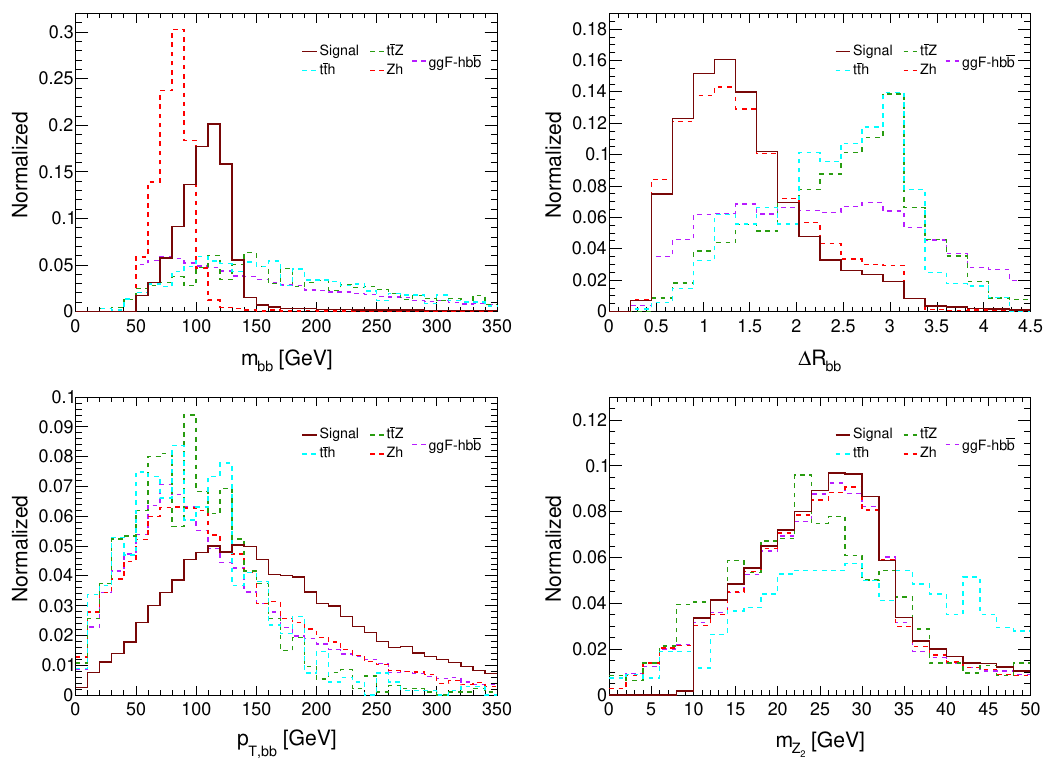
Figure 12 . Normalized distributions of m bb , ∆ R bb , p T,bb and m Z dominant backgrounds after the acceptance cuts and the generation level